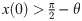
Use of the parameterised model to predict and explore cell–cell variability in SPoC mutants.(A) Simulated exit times of bub2Δ and kin4Δ cells with misaligned spindles, from 10,000 runs of the model. (B) Schematic of a kar9Δ osTIR1 dyn1-AID cell, showing the spindle angle x(t) and the half-angular neck width, ϑ. (C) Simulations of x(t), the spindle angle starting from uniformly distributed initial conditions and varying as a Brownian motion. The time until alignment Ai is indicated for each simulation. A1 = 0 as in this case, the initial condition of the simulation is within the bud neck (x(0)>π2−θ), corresponding to the scenario where the spindle is aligned at the point of extension. A2 and A3 can be measured as the point where x(t) crosses either of the boundaries, as it is not important which SPB enters the bud. The final 2 simulations do not achieve alignment during the 60 minutes simulated so A4,A5>60. (D) The distribution of exit times, E, for a simulated bub2Δ mutant and the distribution of alignment times, A, for a simulated kar9Δ osTir1 dyn1-AID cell. These distributions were inferred from cubic spline interpolation of histograms generated from 10,000 runs of the model or 10,000 Brownian motion simulations respectively. (E) Distribution of the difference between exit time and alignment time, D, for the simulated bub2Δ kar9Δ osTir1 dyn1-AID. The area between the x-axis, the curve, and x = 0 gives the predicted probability of a given cell exiting mitosis before spindle alignment occurs, giving rise to a multinucleate cell. (F) Predicted proportions of multinucleate cells for various genetic backgrounds. Dotted lines show the measured proportions of multinucleate cells in Falk and colleagues [46]. *CDC15-7A MOB1-2A was not included in the assays of Falk and colleagues [46] and so no dotted line is included. Example data can be found in S9 File. SPB, Spindle Pole Body; SPoC, Spindle Position Checkpoint.